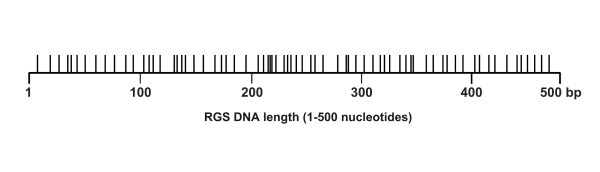
Distribution of point mutations along the 500 bp RGS. The spread of Qβ replicase generated mutations along the length of the RGS indicated that Qβ replicase substituted bases randomly across the full length of the RGS mRNA template with no obvious mutational hot-spots. A total of 41,280 bases were sequenced and all point mutations identified were plotted.